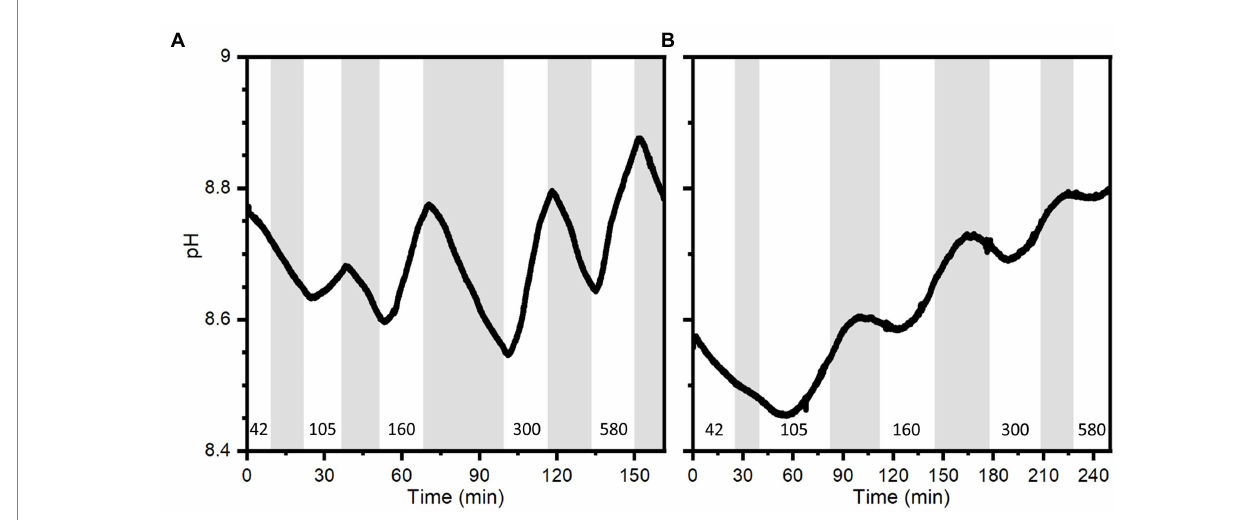
FIGURE 10 pH dynamics measured with a pH microsensor positioned at a depth of 1.6 mm into the bell of a small medusa (A) and 2 mm into the bell of a large medusa (B) during experimental light–dark shifts. Gray areas indicate dark shifts and white areas indicate photo periods of increasing incident photon irradiance (400–700 nm) noted with numbers in units of μ mol photons m − 2 s − 1 . Note difference in x